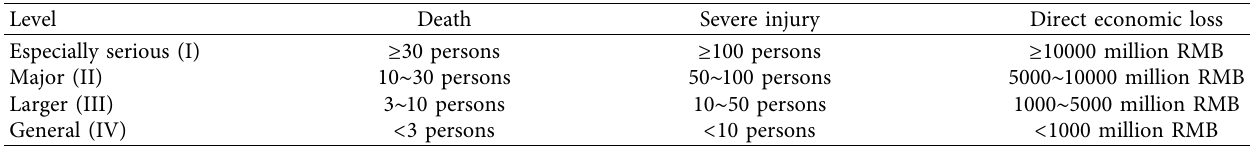
Figure 1: Structured emergency exercise scenario model. Table 1: Criteria for dividing emergency levels.